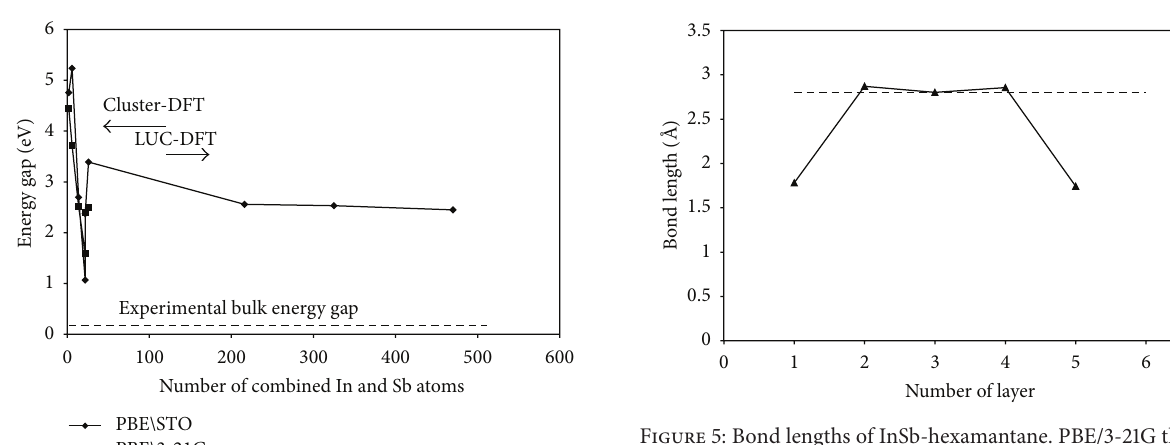
Figure 5: Bond lengths of InSb-hexamantane. PBE/3-21G theory is used for the calculations of this figure. The dashed line represents the experimental bulk value of In–Sb bond length